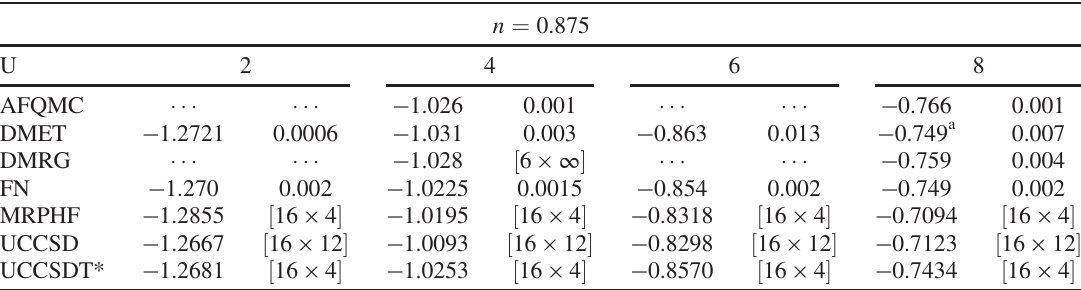
½ 16 × 4 (cid:4) − 0 . 7434 ½ 16 × 4 (cid:4) a Due to strong spatial inhomogeneity observed at this filling, the TL extrapolated number in the table is not meaningful, as different cluster shapes show different orders. Out of the clusters used here, the 8 × 2 impurity cluster is likely the best estimate with E = t ¼ − 0 . 755 ð(cid:2) 0 . 007 Þ . An exhaustive study of the DMET cluster size dependence at this filling will be carried out in the